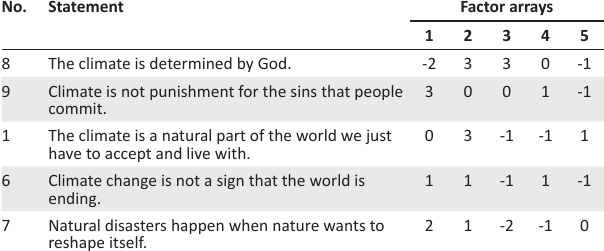
TABLE 3: Q-sorts related to climate change and religious beliefs.